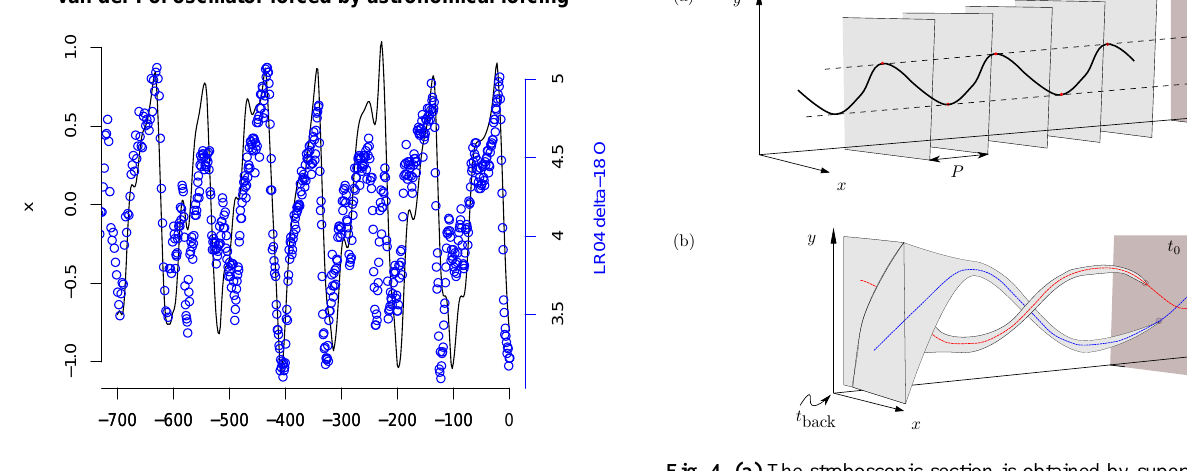
1 This property derives from the system invariance with respect a time translation by P . There will be, however, cases where dif- ferent initial conditions will create different stroboscopic plots. For example two 1 : 2 synchronisation regimes co-exist in the forced van der Pol oscillator, so that there are four distinct local pullback attractors, while only two points will appear on a stroboscopic plot started from a single set of initial conditions. Rigorously, the global pullback attractor at time t is identical to the global attractor of the iteration t + nP , and the global pullback sections at two times t and t 0 are homeomorphic.